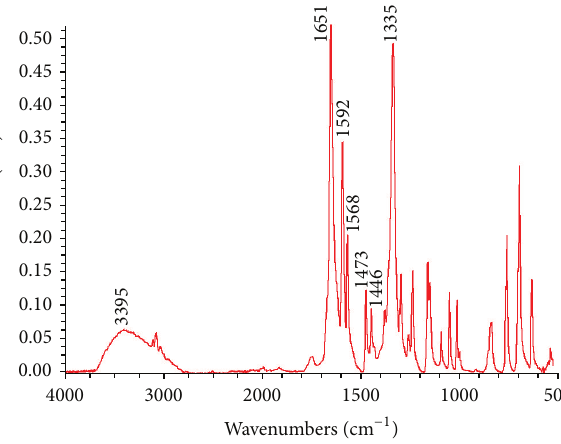
Figure 3: Infrared spectrum (4000–500 cm −1 ) of PA:NC via syn- thetic Route 1 (water